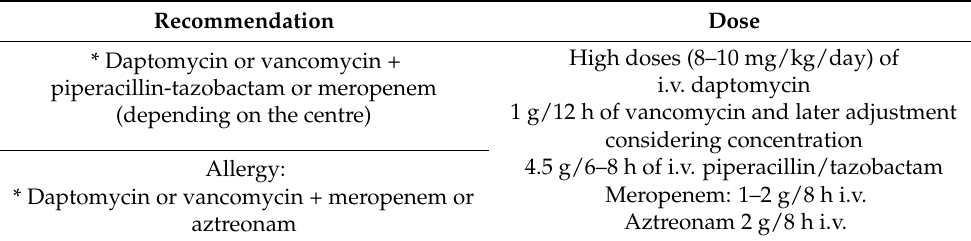
i.v.Allergy: * Daptomycin or vancomycin + meropenem